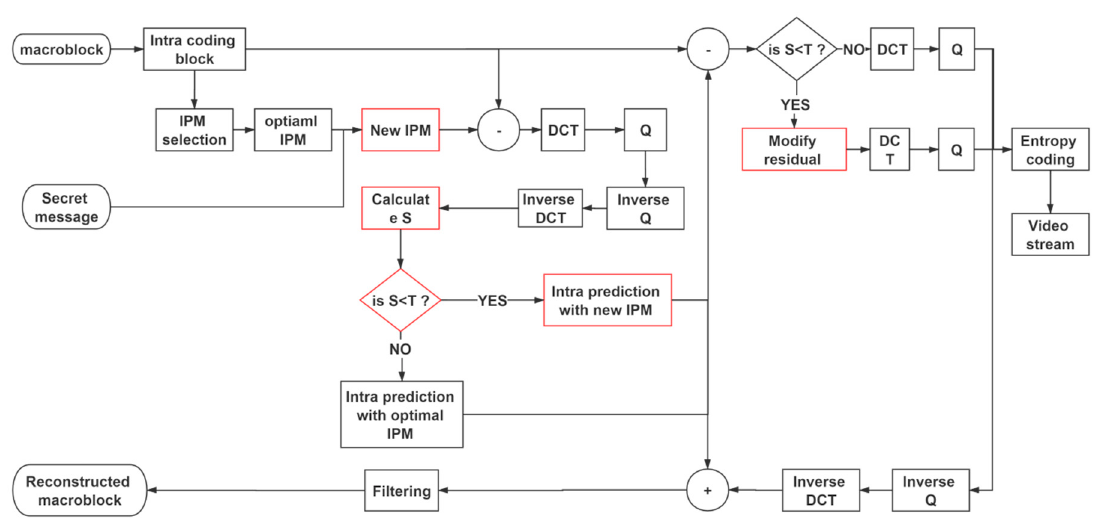
Figure 2. Procedure of embedding a message.